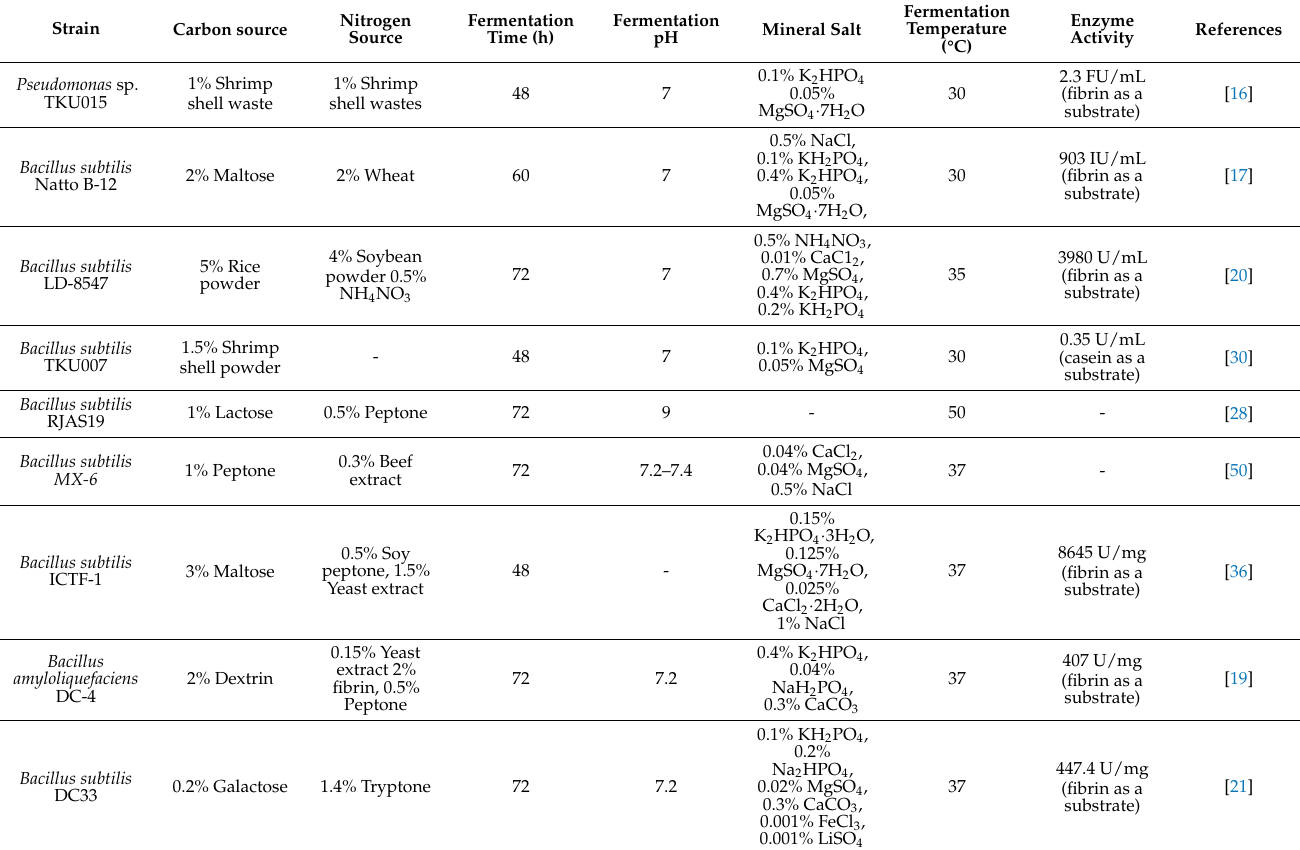
Table 2. Liquid fermentation conditions for